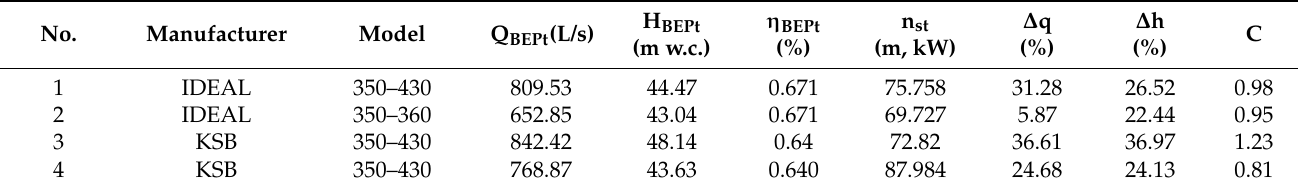
Table 2. Preselected machines in turbine mode and value of